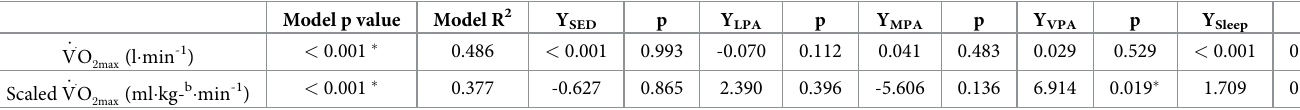
and scaled _ V _ O 2max 2max